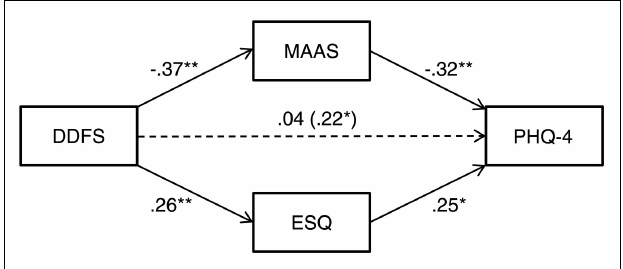
FIGURE 2 | Multiple mediation model of Study 2 scales. DDFS, Daydreaming Frequency Scale; MAAS, Mindful Attention Awareness Scale; ESQ, Internal and External Encoding Style Questionnaire; PHQ-4, Patient Health Questionnaire-4.Values next to each line represent the standardized coefficient of each path.Value between rows represents the total effect of the DDFS on the PHQ-4. *Significant at p < 0.05 (two-tailed); **significant at p < 0.01